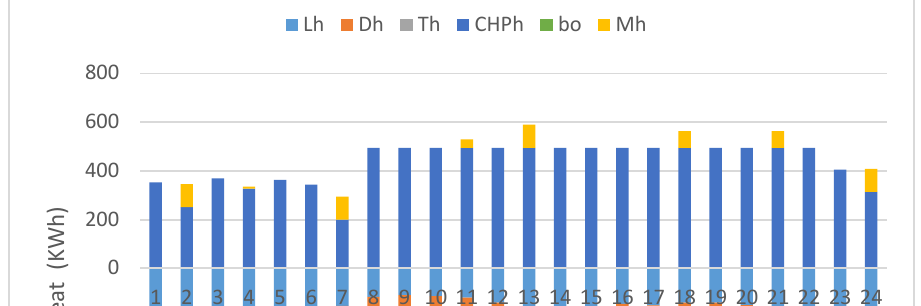
Figure 15. Electric portion in the MCMG.